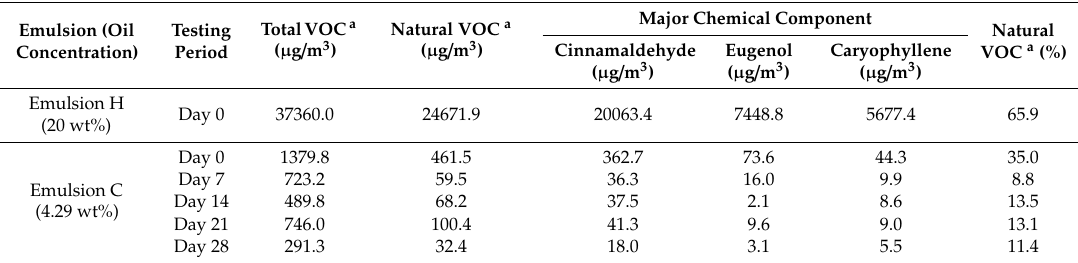
Table 6. Release profile of major chemical components emitted from nanofibrous membranes containing cinnamon